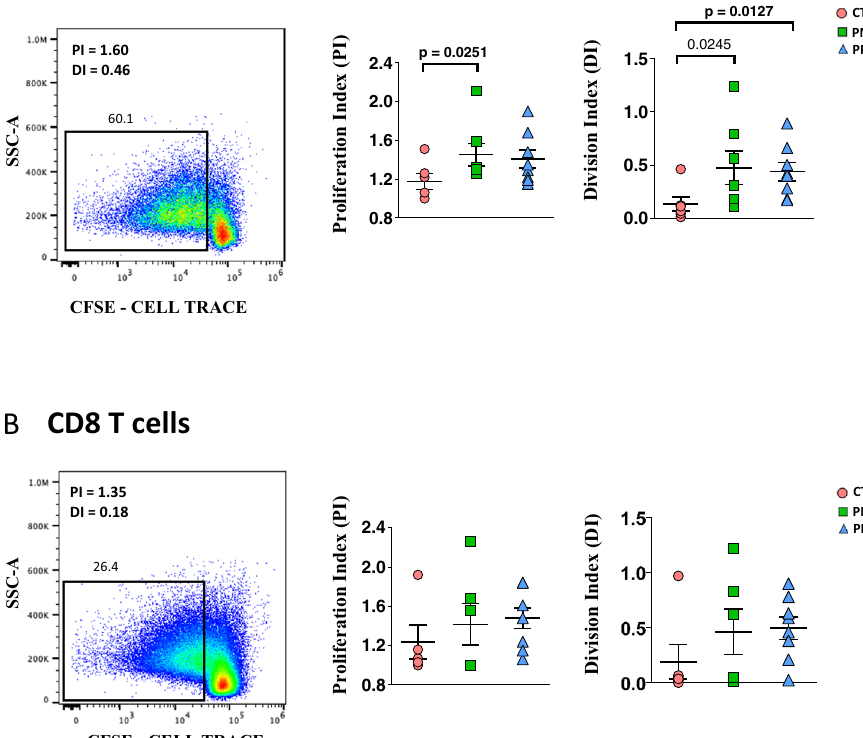
Fig. 7 Proliferation of CD4 and CD8 T cells of COVID-19 pregnant women. A . Proliferation index (PI) and division index (DI) in all CD4 + T cells from the three groups studied. Data represent individual values (dots) from healthy donors (CTR, n = 5), pregnant negative (PN, n = 6), and pregnant positive (PP, n = 7). Values (dots) for the three conditions are matched with the color used in Figs. 1 – 5. Data represent individual percentage values (dots), mean (center bar) and SEM (upper and lower bars). Two-tailed Mann – Whitney t -test with Bonferroni correction has been used. The exact p -value is indicated in the fi gure, if signi fi cant. B . Proliferation index (PI) and division index in all CD8 + T cells from the three groups studied. Data represent individual values (dots) from CTR ( n = 5), pregnant negative (PN, n = 6), and pregnant positive (PP, n = 7). Values (dots) for the three conditions are matched with the color used in Figs. 1 – 5. Data represent individual percentage values (dots), mean (center bar), and SEM (upper and lower bars). Two-tailed Mann – Whitney U -test with Bonferroni correction has been used. The exact p -value is indicated in the fi gure, if signi fi